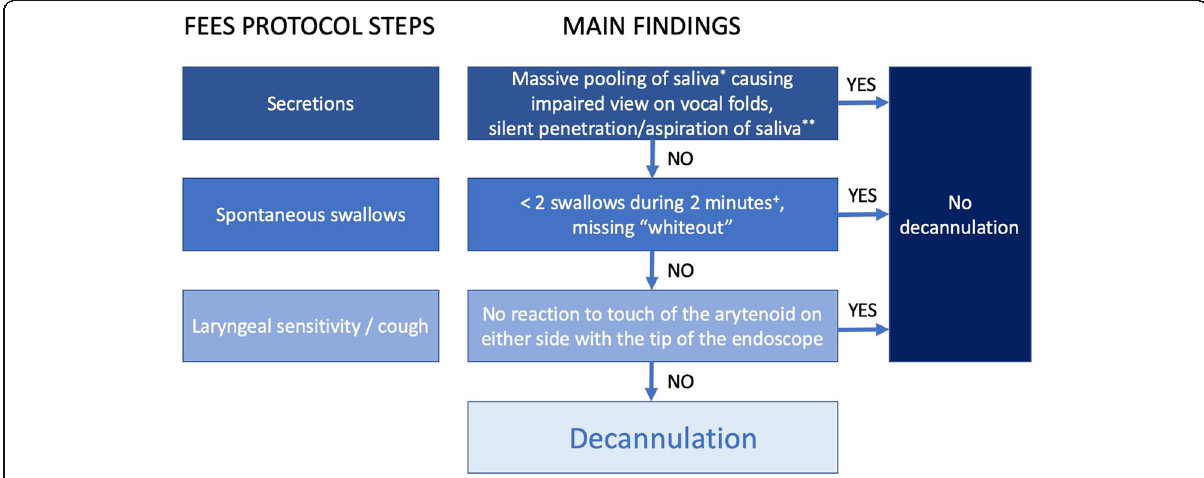
Fig. 1 Stepwise evaluation of swallowing function according to the “ Standardized endoscopic Swallowing Evaluation for tracheostomy decannulation in critically ill neurologic patients ” ; *not only coating; **permanently without any reaction; + if exactly two swallows occur in this period, another two minutes of observation are recommended; (adapted from [6]: Warnecke T, Suntrup S, Teismann IK, Hamacher C, Oelenberg